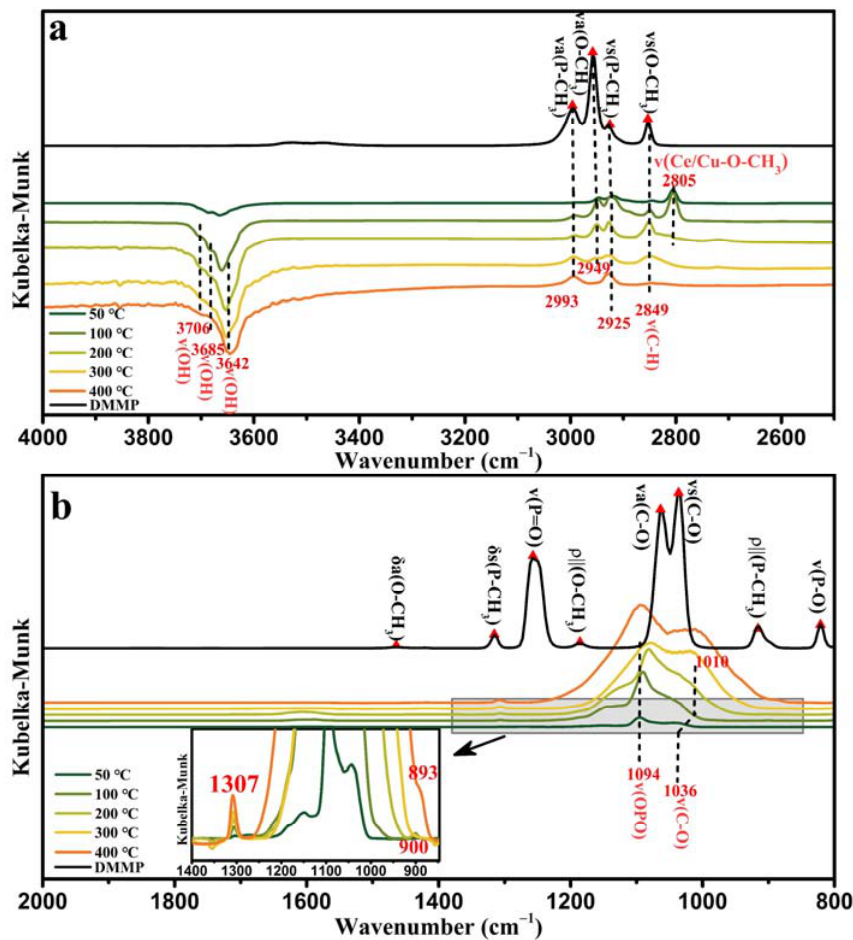
Figure 16. In situ DRIFTS spectra of 50%Cu/Ce at varying temperatures in ( a ) the high-frequency region and ( b ) in the mid–low frequency region, the inset is a magnified image of the tagged area. Table 9. IR frequencies and assignments of the surface species.